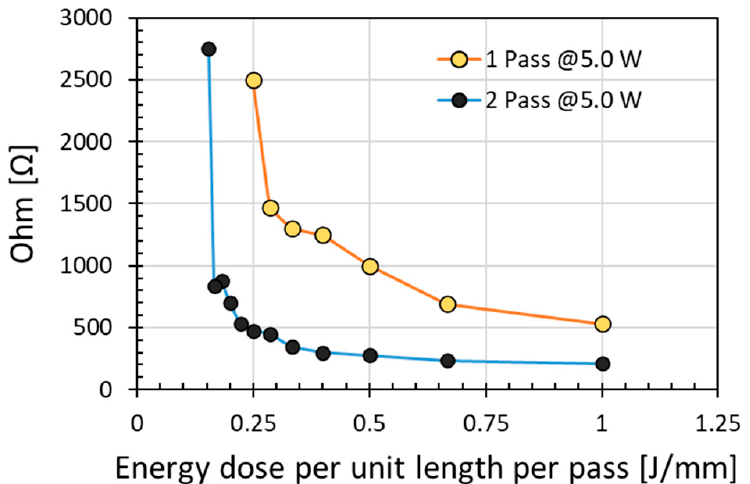
Figure 2. Electrical resistance increased with energy dose per unit length applied to irradiate polyimide surface (power of 5.0 W with corresponding power density of 3.44 W/cm 2 ). Reducing the scanning speed was not effective in compensating the decreasing laser power to result in low electrical resistance. This clearly indicates that a certain laser